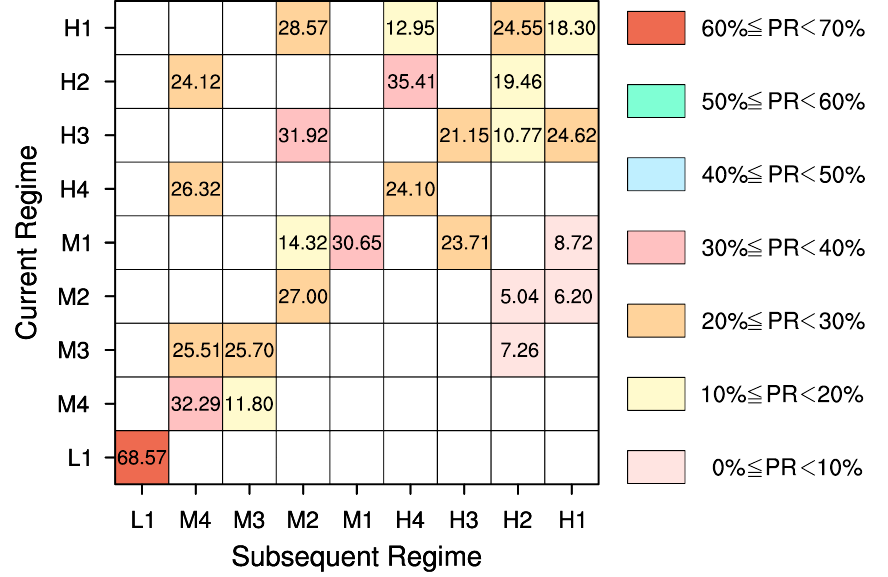
Figure 13. The occurrence frequencies of transformations (PR; units: %) from each of the nine regimes (ordinate) to each of the nine regimes (abscissa). Note that PRs along the diagonal denote the frequencies of persistence for the nine regimes. Only PRs with statistical significance are shown and the statistical test can be referred to in Section